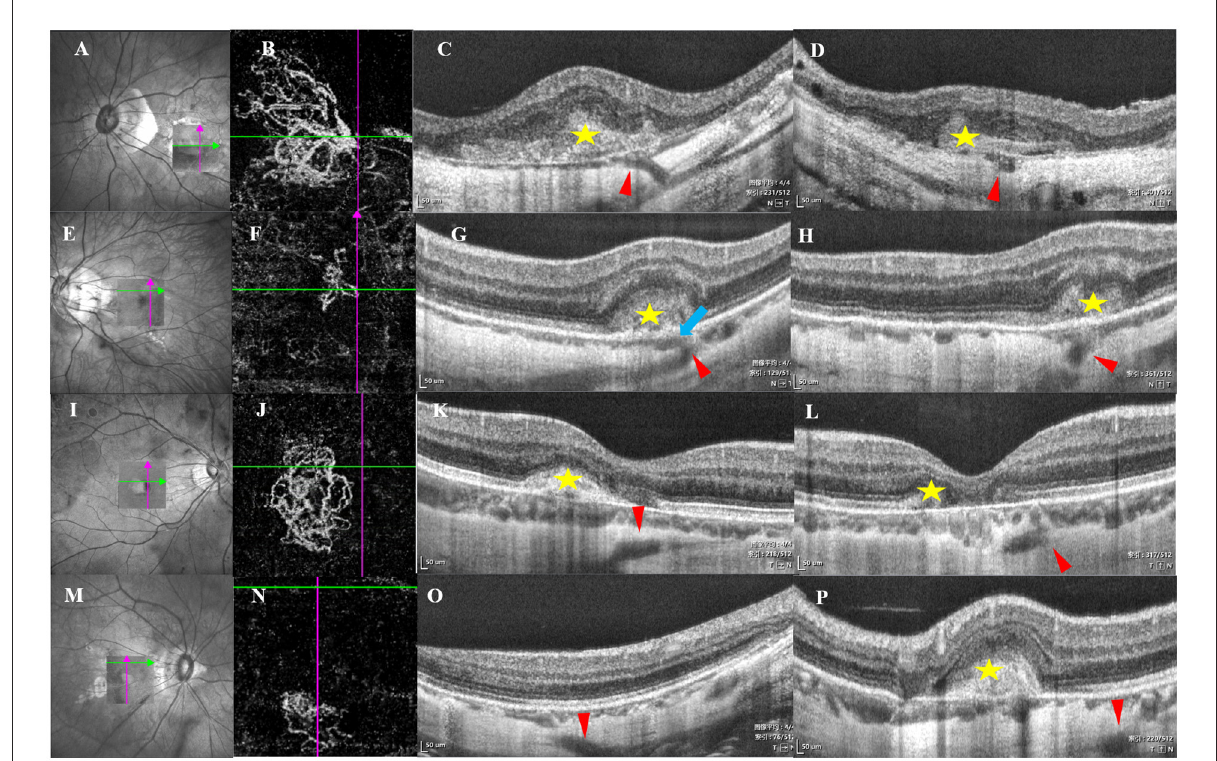
FIGURE1 B-scan imaging of perforating scleral vessels (PSVs) with myopic choroidal neovascularization (mCNV) using swept-source-OCT (SS-OCT). The left arrow indicated the scanning laser ophthalmoscopy images, and the box indicated the scan area by SS-OCT. The second arrow indicated choroidal neovascularization (CNV) by optical coherence tomography angiography (OCTA), the cross lines indicated the location of PSV, and the right two arrows indicated horizontal and vertical B-scan images corresponding to the location of the left and second arrows. (A–D) The PSV adjacent to choroidal neovascularization (CNV), the red arrowhead indicated the PSV, which looked like an intrascleral low-reflection lumen-like and linear hyporeflective structure entering obliquely from the scleral regions, yellow star stands for mCNV, Bruch’s membrane was defective and continuous with PSVs, a hollow hyporeflective space stands for PSVs at the vertical orientation corresponding to B, the hyporeflective structure was adjacent to CNV by defective Bruch’s membrane. (E–H) PSVs penetrated into the dilated choroidal vessels under mCNV. The red arrowhead indicated the PSVs, a linear hyporeflective structure that protruded into the choroidal compartment and branched out to the enclosed and enlarged hyporeflective spaces, which indicated the dilated choroidal vessels (blue arrow). An enlarged hyporeflective space was detected in H, indicating PSVs, dilated choroidal space was near the PSVs. (I–L) The PSV (red arrowhead) passed under mCNV (yellow star). (M–P) The PSV (red arrowhead) was far away from mCNV (yellow